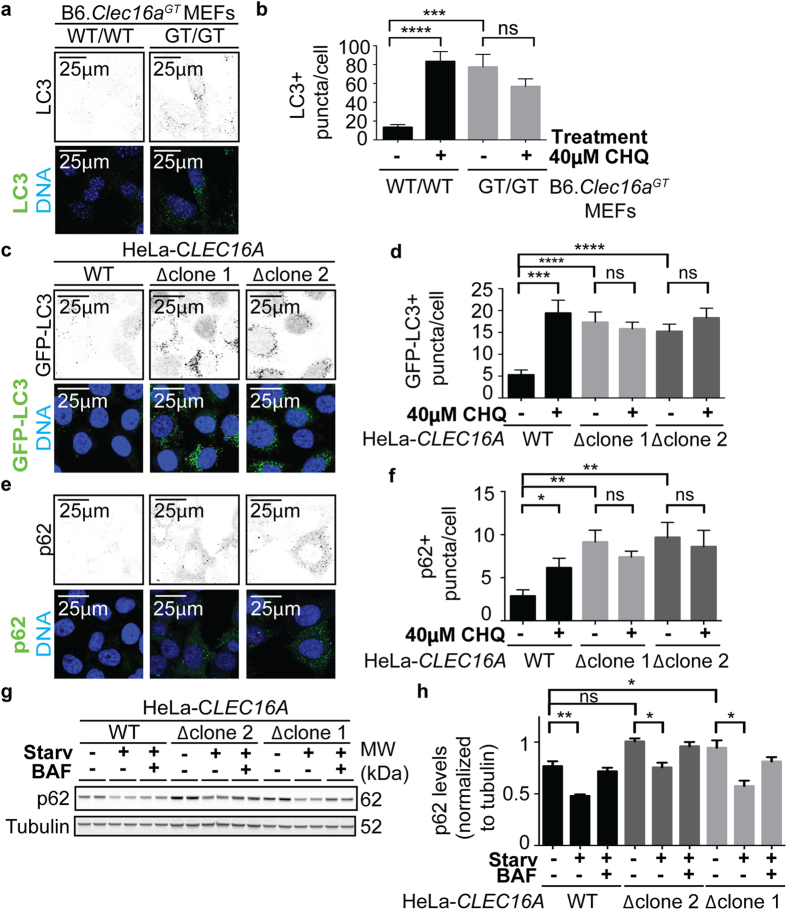
Increased LC3 and p62 in Clec16a-mutant MEFs and HeLa cells.(a,b) B6.Clec16aGT MEFs, untreated or treated with 40 μm chloroquine were imaged by confocal microscopy (a) and the number of LC3+ puncta/cell was quantified (b) (representative of n = 3 experiments, minimum 100 cells/condition quantified/experiment). (c–f). HeLa-CLEC16A cells, untreated or treated with 40 μm chloroquine were imaged by confocal microscopy (c,e) and the number of GFP-LC3+ (d) or p62+ (f) puncta/cell was quantified (representative of n = 3–5 experiments, minimum 100 cells/condition quantified/experiment). (g,h) A representative western blot of p62 in indicated cells starved (Starv) or treated with Bafilomycin A1 (BAF) (g), quantified by p62 levels over tubulin (h) (representative of n = 3 experiments). Data represent mean+/− s.e.m. and are analyzed by unpaired Student’s t-test; *P < 0.5, **P < 0.01, ***P < 0.001, ****P < 0.0001, ns =  not significant. Scale bars indicate 25μm (a,c,e).